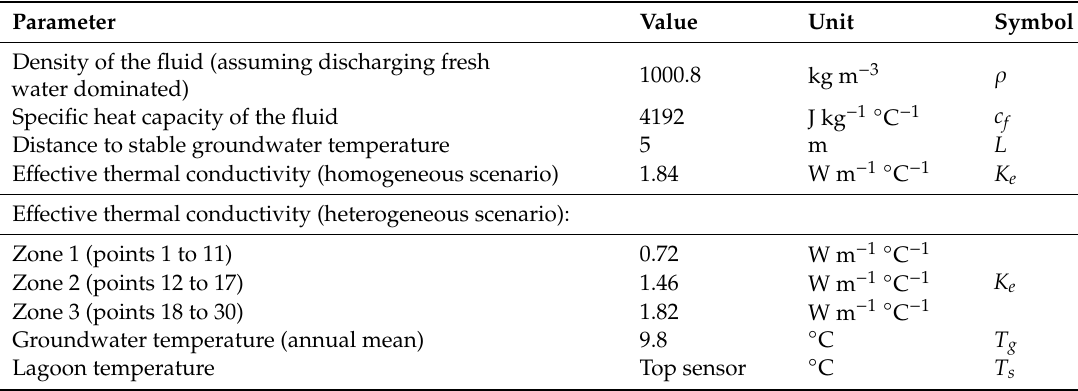
Table 1. The parameters used for the application of a steady-state analytical solution (BP). Parameter Value Unit Symbol Density of the fluid (assuming discharging fresh water dominated) Distance to stable groundwater temperature E ff ective thermal conductivity (homogeneous scenario) E ff ective thermal conductivity (heterogeneous scenario): Zone 1 (points 1 to